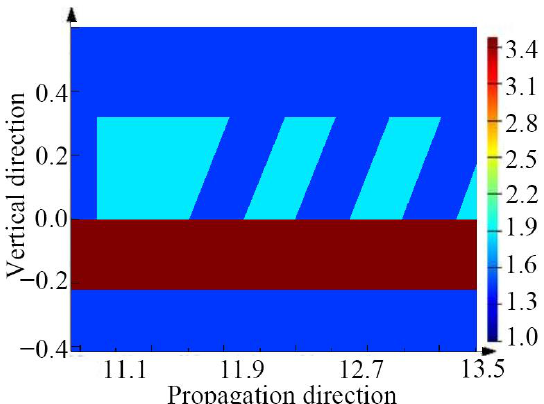
Figure 2. The partial refractive index profile of the antenna.